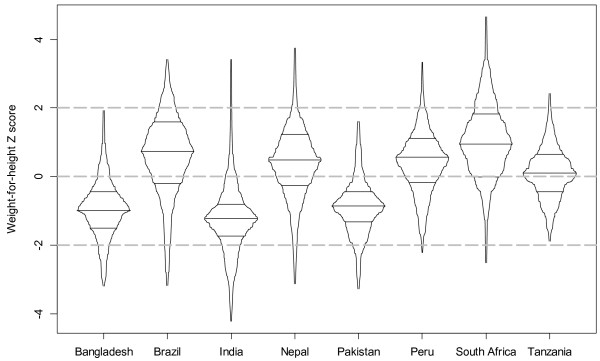
Box-percentile plots of weight-for-height (WHZ) by country; 2009–10.